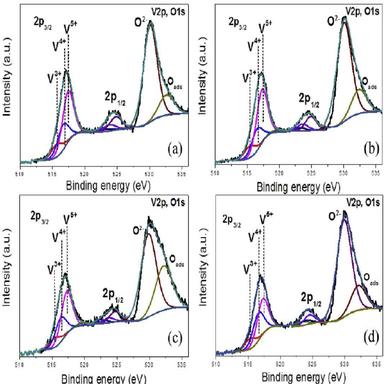
The typical, illustrative, curve fitted V2p and O1s spectra of the as deposited (a) FVO, (b) Mo-FVO, (c) W-FVO and (d) Ti-FVO thin films on the Al6061 substrates.